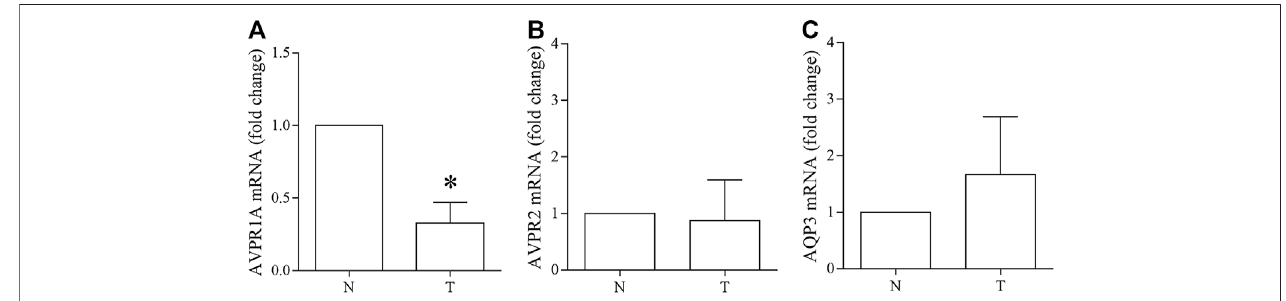
FIGURE12| Vasopressinreceptors and AQP3geneexpression inhuman coloncarcinomabiopsies. Real-Time PCRwasperformedasdescribed inthemethods (A) Real-time PCR experiments show that the V1aR expression is signi fi cantly downregulated in the tumor biopsies compared with the corresponding healthy mucosa. (B – C) NorelevantchangeswerefoundintheexpressionofV2RandAQP3.Dataareshownasmean±S.E.M.andanalyzedbyStudent ’ s t -test(* p <